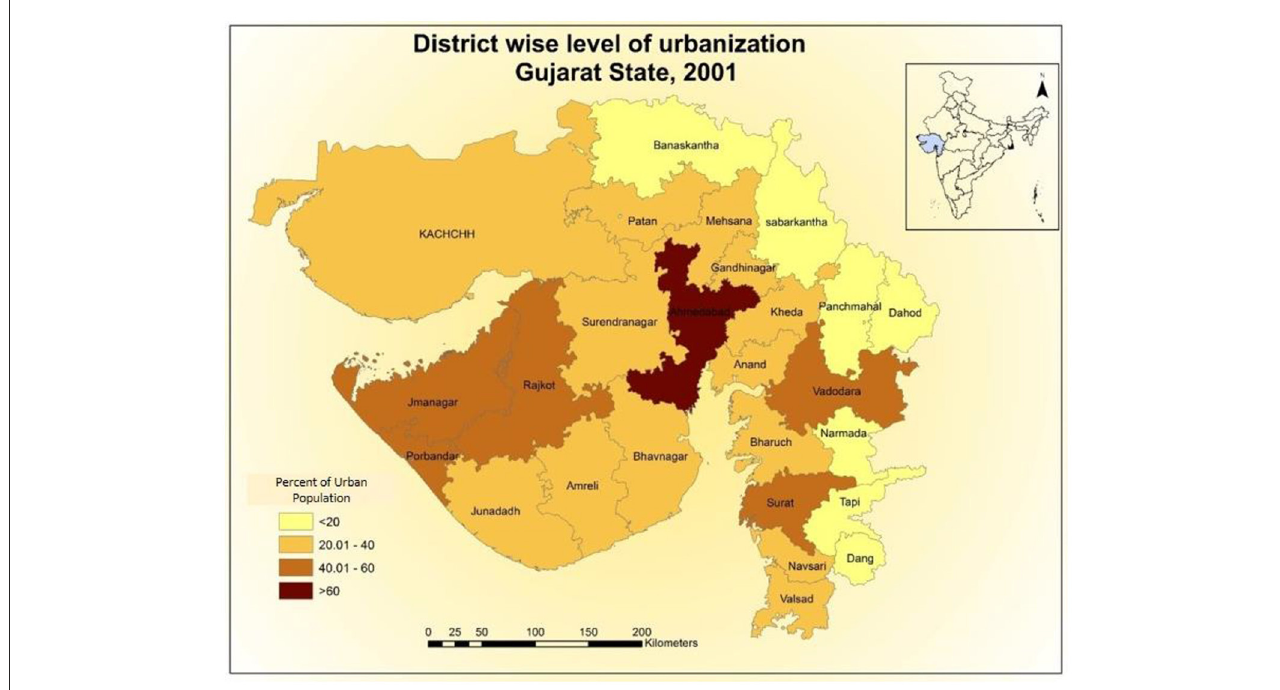
FIGURE2 District-wise level of urbanization, Gujarat-2001. Source: Prepared by the Authors, 2019.